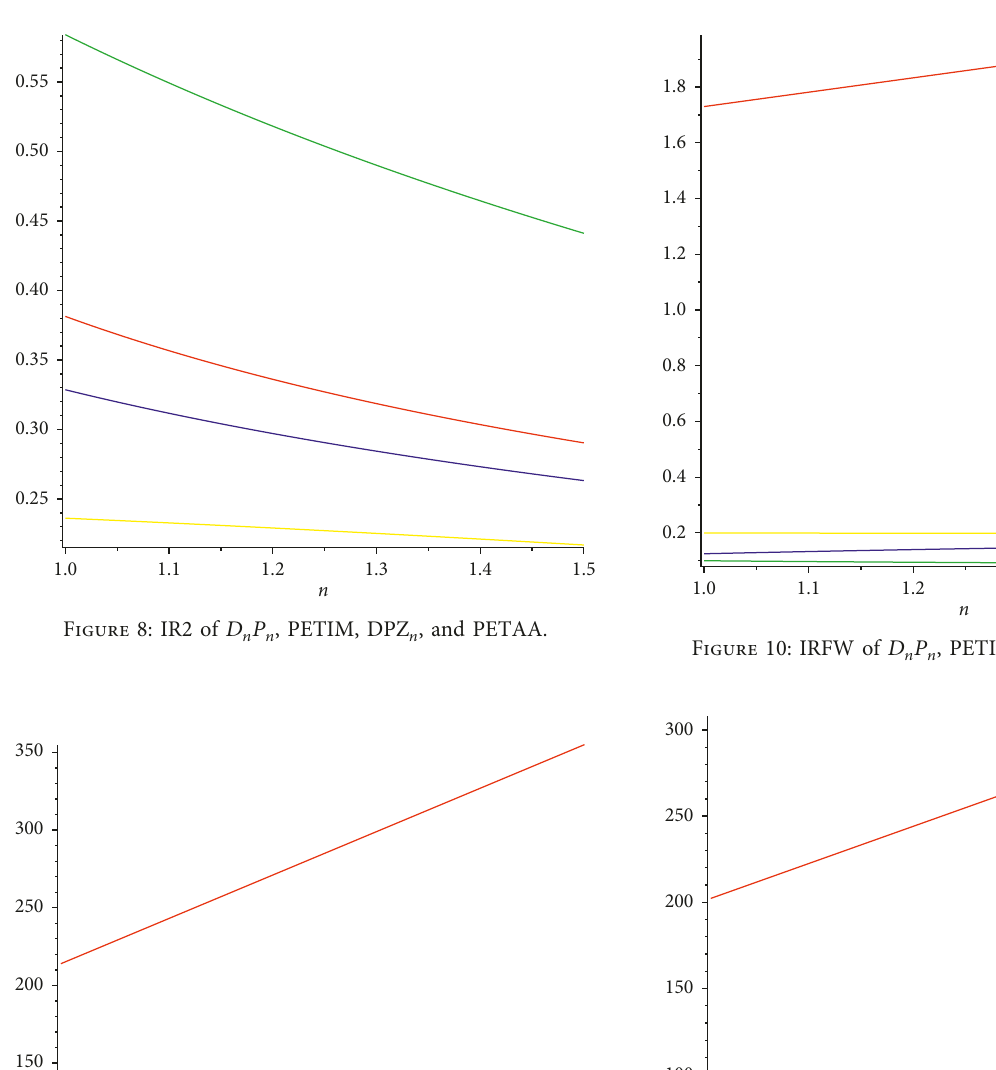
Figure 11: IRA of D